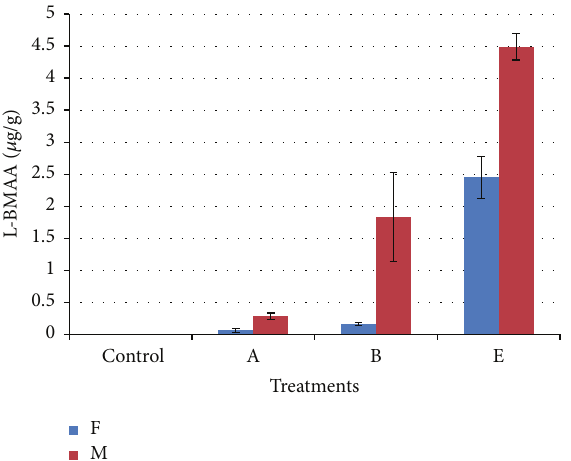
Figure 3: Comparison of L-BMAA concentrations ( 𝜇 g/g) in brains of male and female mice as detected by UPLC-UV. T-bars represent the mean of 𝑛 (𝑛 = 3 ) ± SD. A, B, and E: mice treated (0.03, 0.3, and 3 mg/g BW)